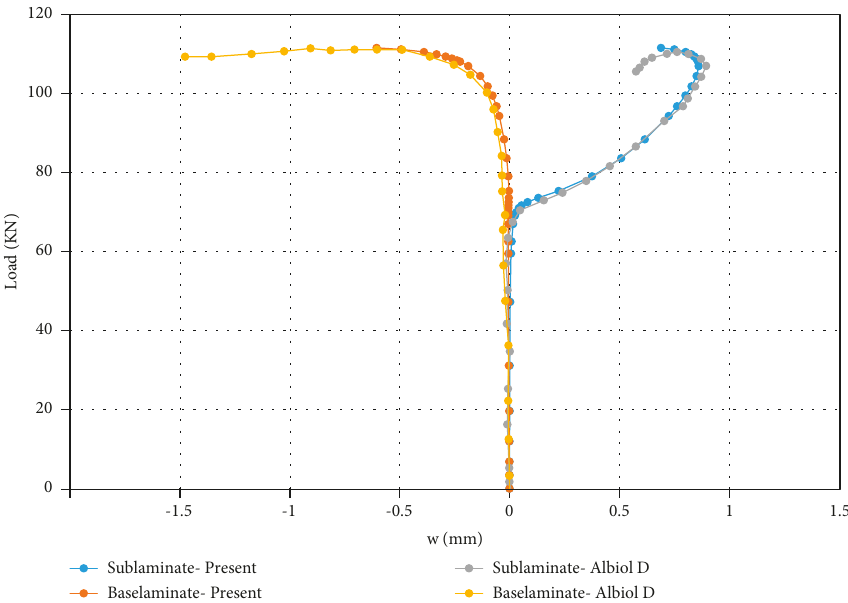
Figure 5: Postbuckling of HTA/6376C plate compared with [48].